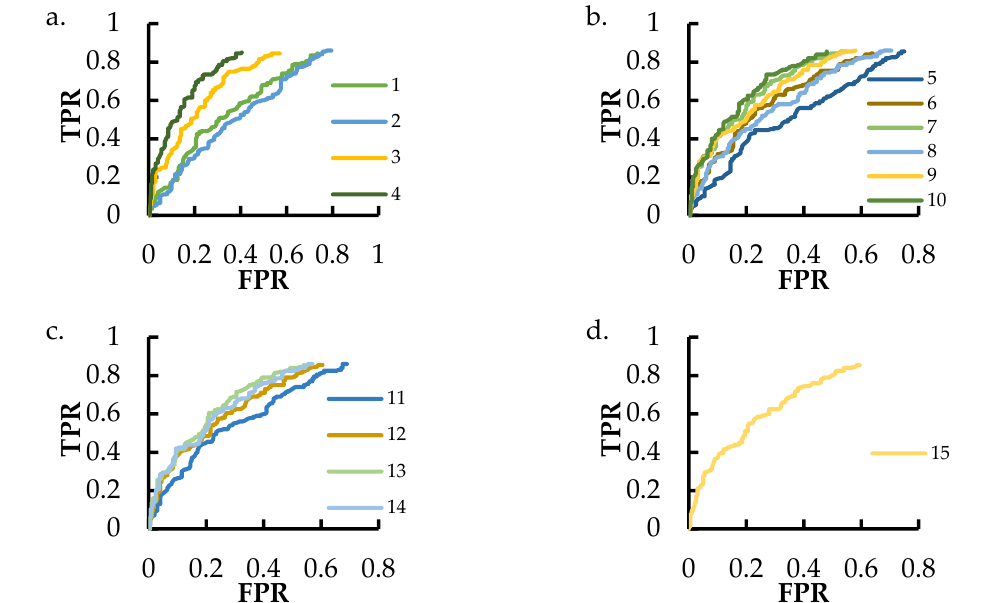
Figure 7. Extraction results of quadrat 1 combination at different phenological stages. ( a ) Single phenophase; ( b ) Combined time series of dual phenology; ( c ) Combined time series of triple phenology; ( d ) Full phenological stage with 1–15 corresponding to the combination numbers of different phenological stages in Table 4. FPR—false positive rate; TPR—true positive rate.